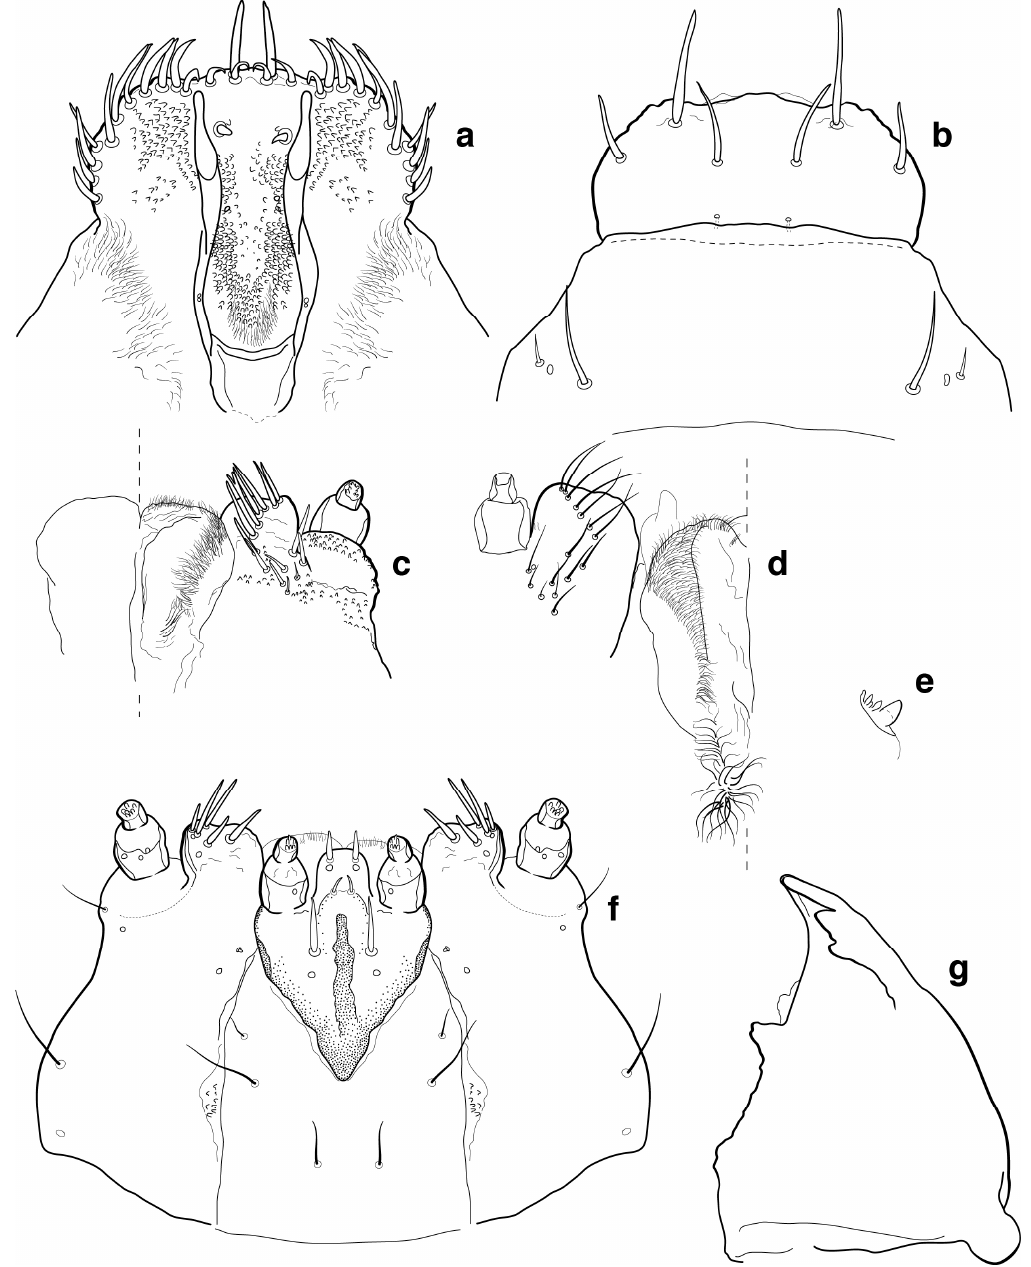
Figure 79. Rhynchophorus palmarum mouthparts: ( a ) epipharynx; ( b ) clypeus and labrum; ( c ) mala and maxillary palp, dorsal view; ( d ) detail, mala and hypopharynx, ventral view; ( e ) maxillae, hypopharynx, labium, dorsal view; and ( f ) labio-maxillary complex, ventral view.